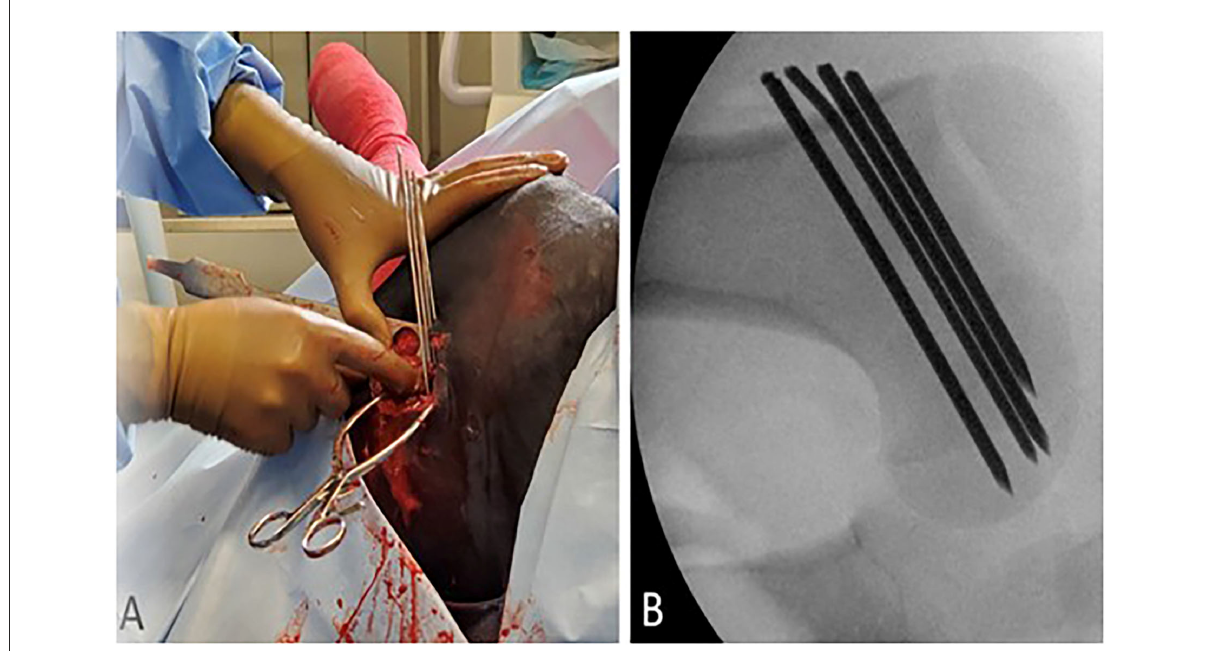
FIGURE2 (A) External visualization of four smooth Steinmann pins placed in a parallel orientation through a skin incision on the lateral proximal femur. (B) Intraoperative fluoroscopic view of final Steinmann pin fixation through the left proximal femoral physis.